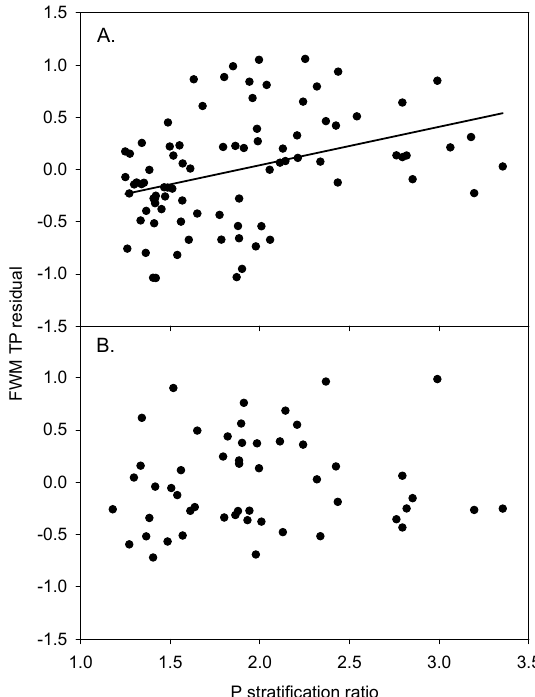
Figure 4. Correlation between residual FWM TP (from regression of agronomic STP (0–20 cm depth) vs. natural log transformed FWM TP concentrations) and the P stratification ratio for tile drainage ( A ) and surface runoff ( B ).